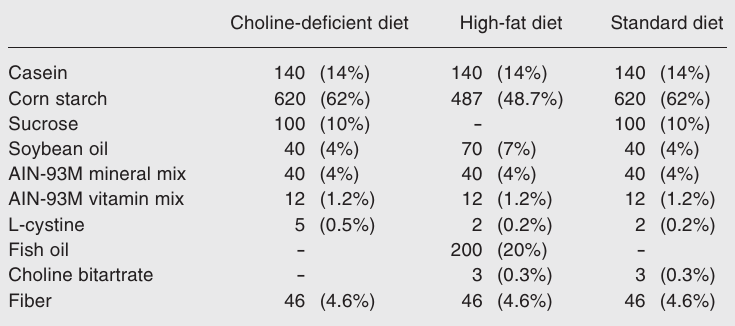
Table 1. Composition of the experimental diets used. Choline-deficient